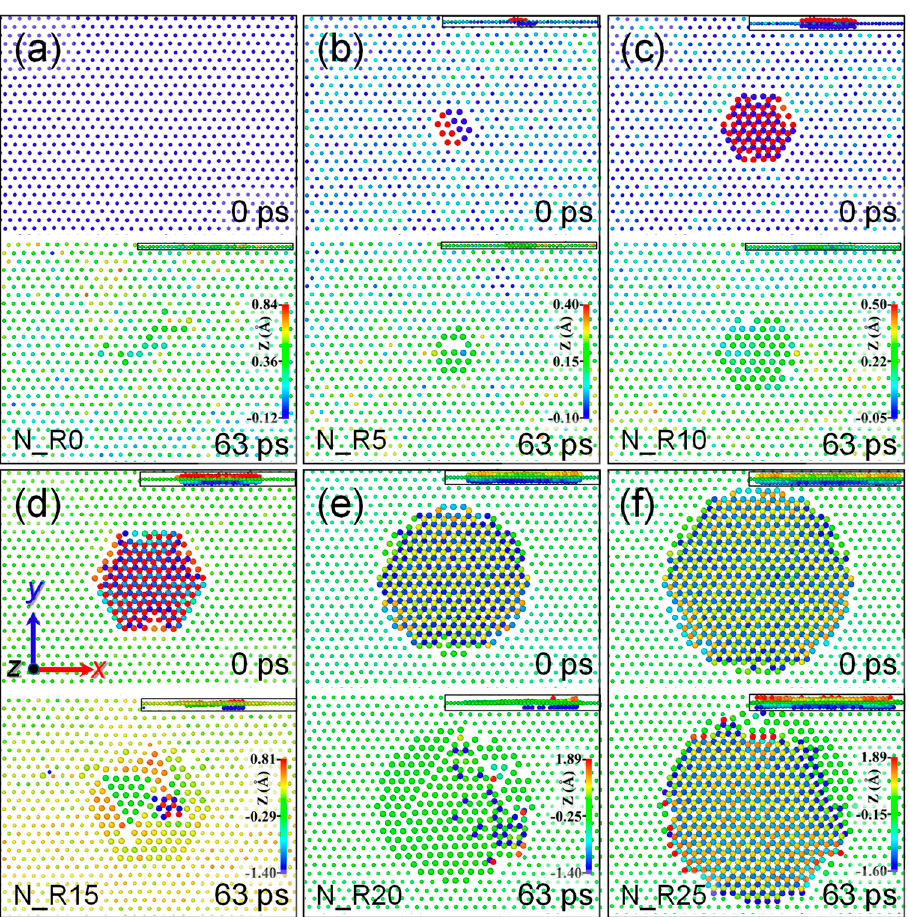
Figure 4. Ni atoms around the intrinsic hole of each pure Ni model. ( a ) N_R0. ( b ) N_R5. ( c ) N_R10. ( d ) N_R15. ( e ) N_R20. ( f ) N_R25. Each panel contains the initial and terminal configurations.